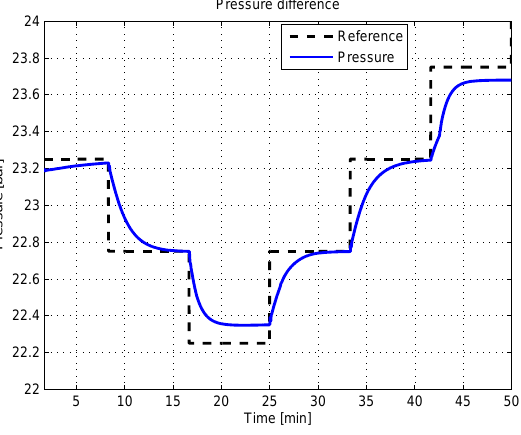
Figure 8: Choke opening